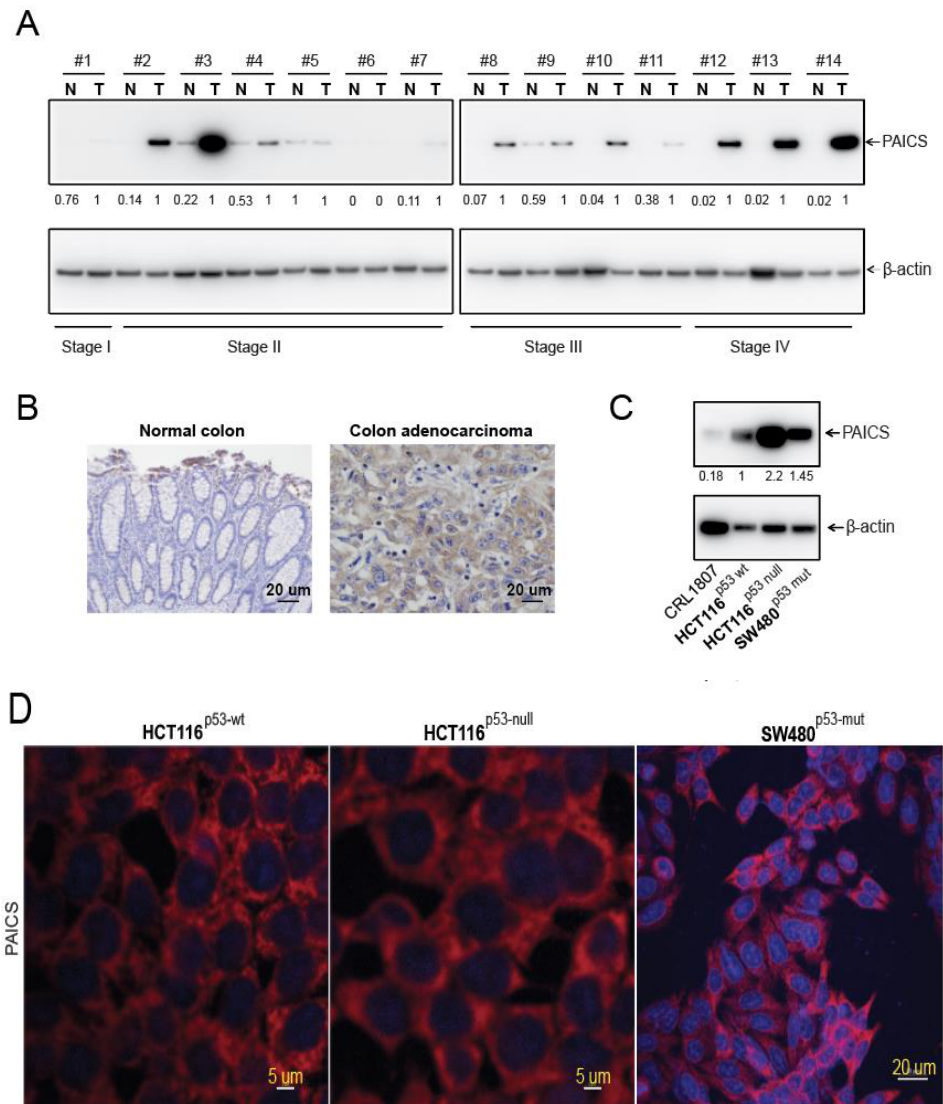
Figure 2. PAICS protein upregulation in CRCs. ( A ) Immunoblot analysis showing stage-wise expression of PAICS in paired CRCs and corresponding normal colorectal tissues. β-Actin was used PAICS in paired CRCs and corresponding normal colorectal tissues. β -Actin was used as a loading control. as a loading control. Densitometric analysis was performed individually for each sample (#1–14) Densitometric analysis was performed individually for each sample (#1–14) having normal (N) and tumor having normal (N) and tumor (T). The numerical values indicate the normalized intensity ratio of (T). The numerical values indicate the normalized intensity ratio of PAICS / β -actin. ( B ) Representative PAICS/β-actin. ( B ) Representative images of immunohistochemical (IHC) analysis of CRC tissue images of immunohistochemical (IHC) analysis of CRC tissue sections showing PAICS reactivity in CRCs sections showing PAICS reactivity in CRCs compared with normal colorectal tissue. Hematoxylin compared with normal colorectal tissue. Hematoxylin was used for nuclear staining; scale bar—20 µ m was used for nuclear staining; scale bar— 20 µm ( C ) Immunoblot analysis showing PAICS expression ( C ) Immunoblot analysis showing PAICS expression across a panel of CRC cell lines. β -Actin was used as a across a panel of CRC cell lines. β-Actin was used as a loading control. ( D ) Immunofluorescence loadingcontrol. ( D )ImmunofluorescenceanalysisshowingPAICScytoplasmiclocalizationinHCT116 p53-wt analysis showing PAICS cytoplasmic localization in HCT116 p53-wt and HCT116 p53-null cells; scale bar— and HCT116 p53-null cells; scale bar—5 µ m and SW480 p53-mut ; scale bar—20 µ 5 µm and SW480 p53-mut ; scale bar— 20 µm.